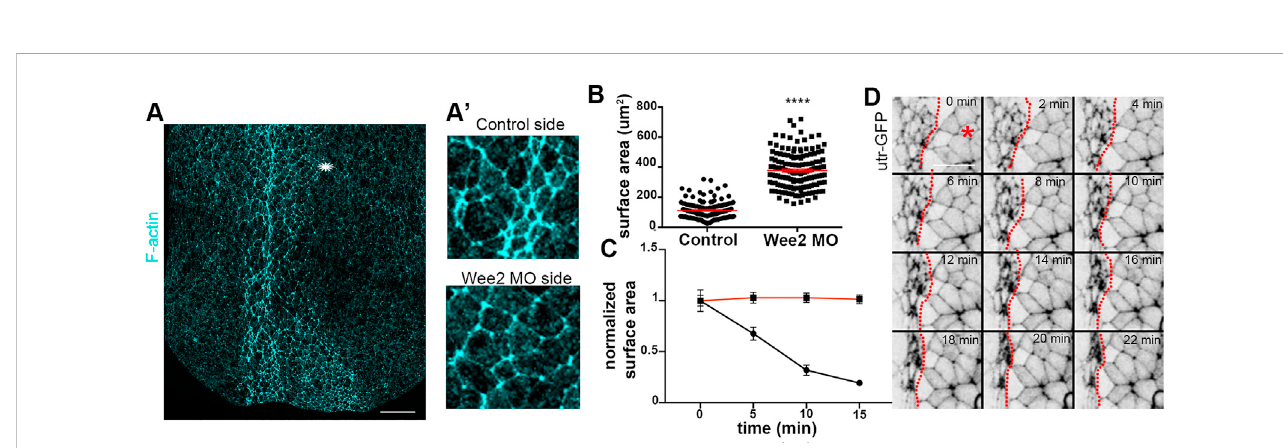
FIGURE 5 Apicalconstrictionwithintheneuroepitheliumisdefectivewhensomiticmesodermmorphogenesisisimpaired. (A) Maximumintensityprojectionimage ofarepresentativestage 16embryo.Asterisk: Wee2somitic mesoderm morphantside.Scale bar:100 μ m (A ’ ) Zoomedimages ofcontrol neuroepithelial cells andneuroepithelialcellsoverlyingWee2morphantsomiticmesoderm.Theapicalsurfaceareaofneuralplatecellsoverlyingthemorphantsomiticmesoderm side is larger compared to that of control cells. (B) Quanti fi cation of apical cell surface area. Two-sided unpaired Student ’ s t -test; **** p < .0001; mean ± SEM; n = 150 cells. (C) Quanti fi cation of apical cell surface area over time from neuroepithelial cells in Movie 4 and panel (D) ; Two-sided unpaired Student ’ s t-test;**** p < .0001; n =20cellsforeachtimepoint.NeuroepithelialcellsoverlyingWee2morphantsomiticmesodermfailtoundergoapicalconstriction (D) Stills from a time lapse recording of a neurula embryo with unilateral Wee2 morphant somitic mesoderm. Red dotted line: neural plate midline. Asterisk: Wee morphant side. Scale bar: 50 μ